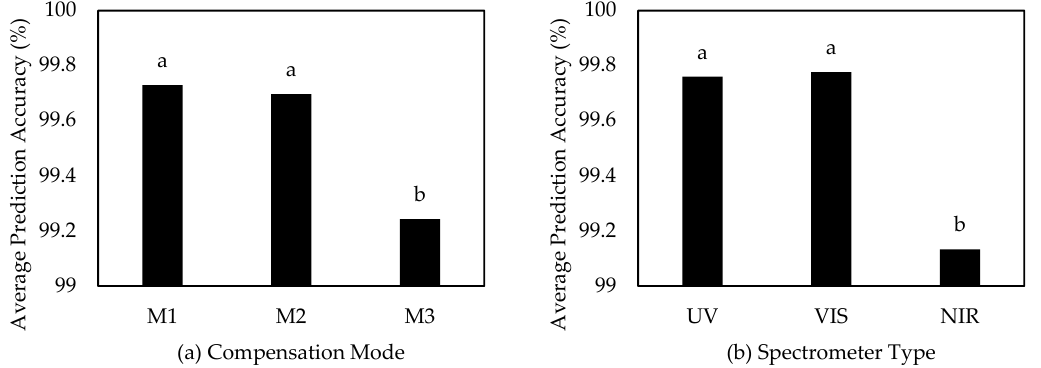
Figure 10. Tukey’s HSD multiple comparison test between di ff erent compensation modes ( a ) and spectrometer types ( b ) using the quadratic discriminant algorithm. Bars denoted with di ff erent letters are significantly di ff erent ( α = 0.05).